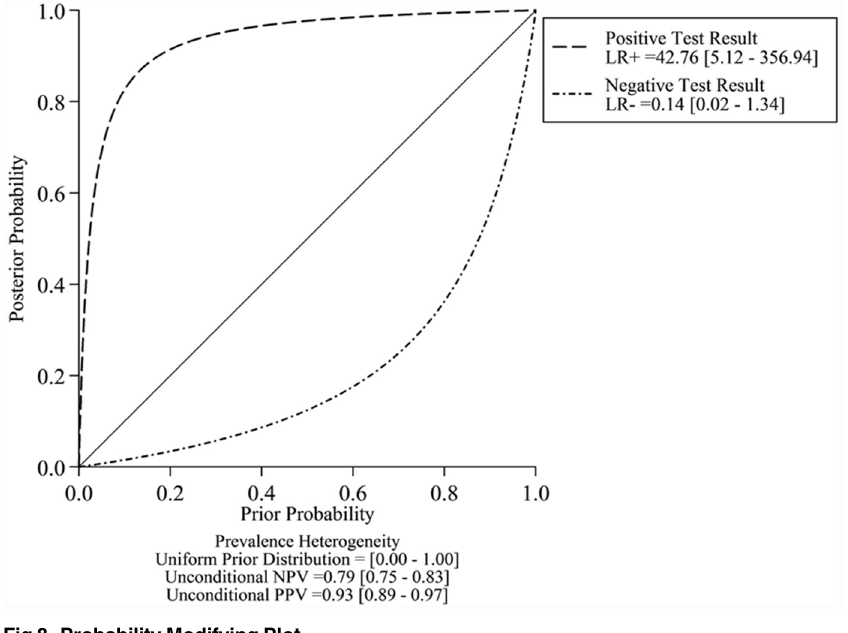
Fig 8. Probability Modifying